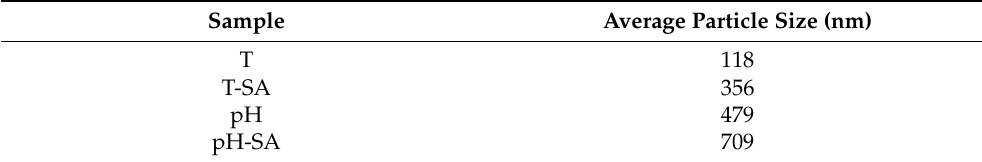
Table 1. The average particle size (nm) of the obtained empty thermo/pH-sensitive carriers and their systems with